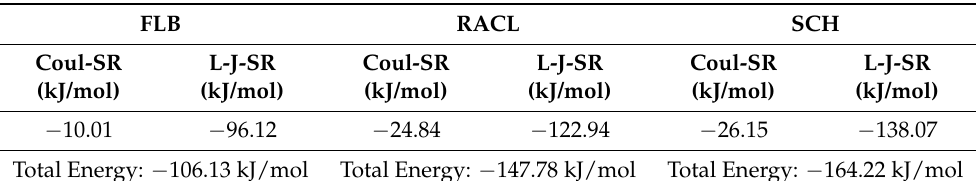
Table 4. Total interaction energies (calculated as the sum between Coulombic and Lennard-Jones interactions) for the three ligands docked at D2DR’s bottom